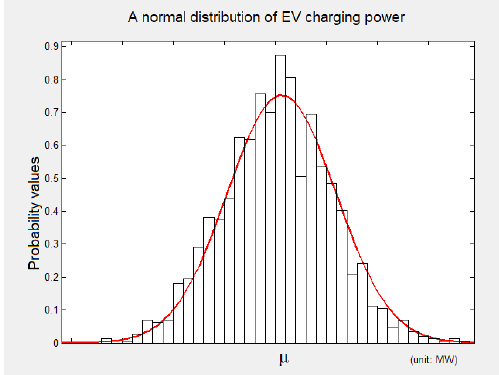
Figure 3. The distribution curve of electric vehicle (EV) charging power.